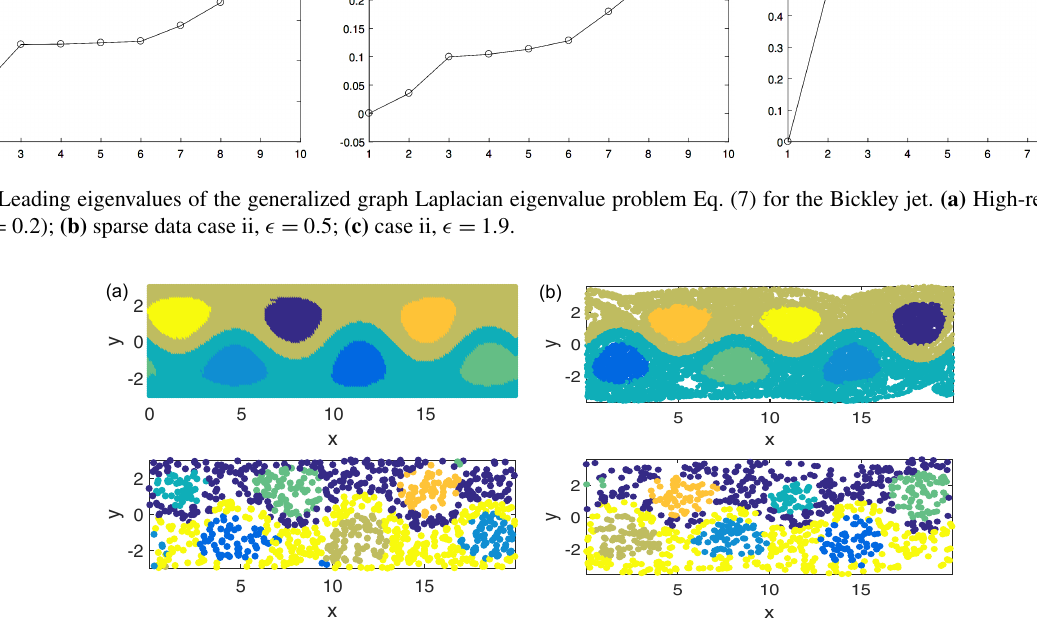
Figure 6. Extraction of eight coherent sets based on a k -means clustering of the eight leading eigenvectors of the generalized eigenvalue problem for the Bickley jet. Coherent sets at initial time ( t = 10, a ) and at final time ( t = 30, b ). Top: high-resolution case (i), (cid:15) = 0 . 2; bottom: 1000 random initial conditions (case ii), (cid:15) = 0 .